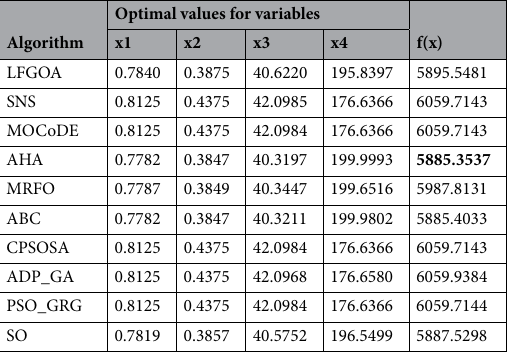
Table 23. Comparison of the best solution for pressure vessel design found by different methods.